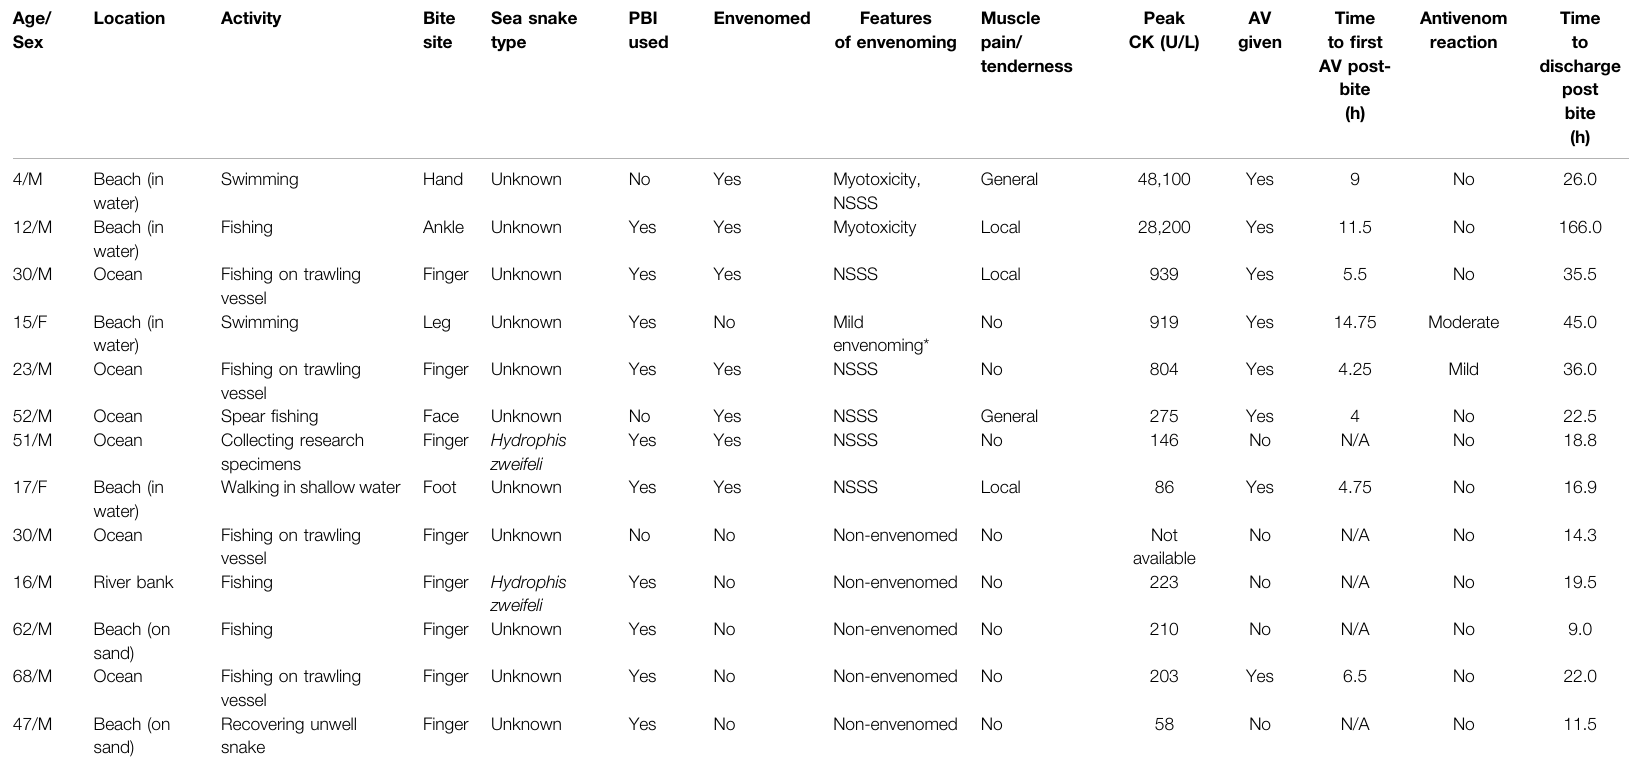
TABLE 1 | Summary of patient characteristics and clinical features of 13 patients with sea snake